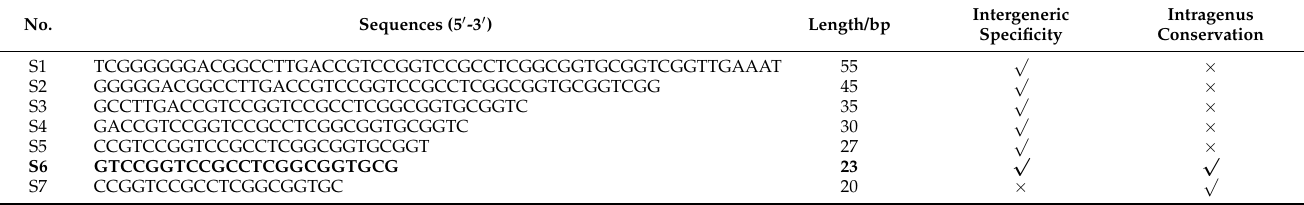
Table 3. BLAST results of the candidate sequences with different lengths in